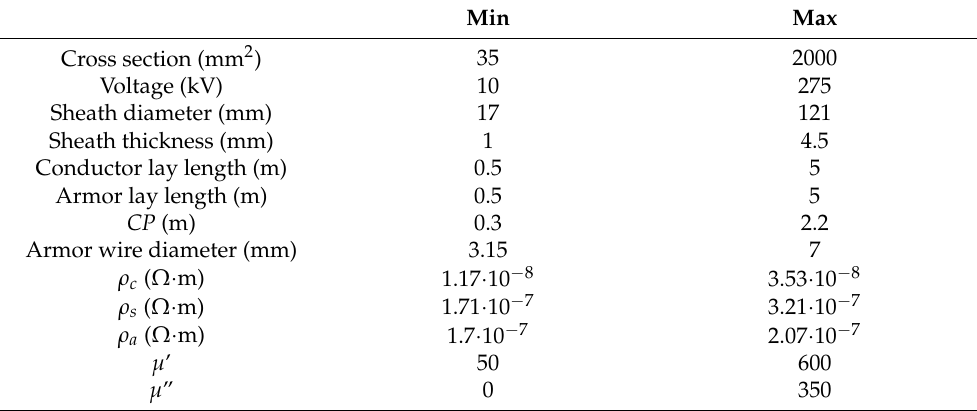
Table 4. Maximum and minimum values of the main numerical parameters of all TCACs simulated. Min